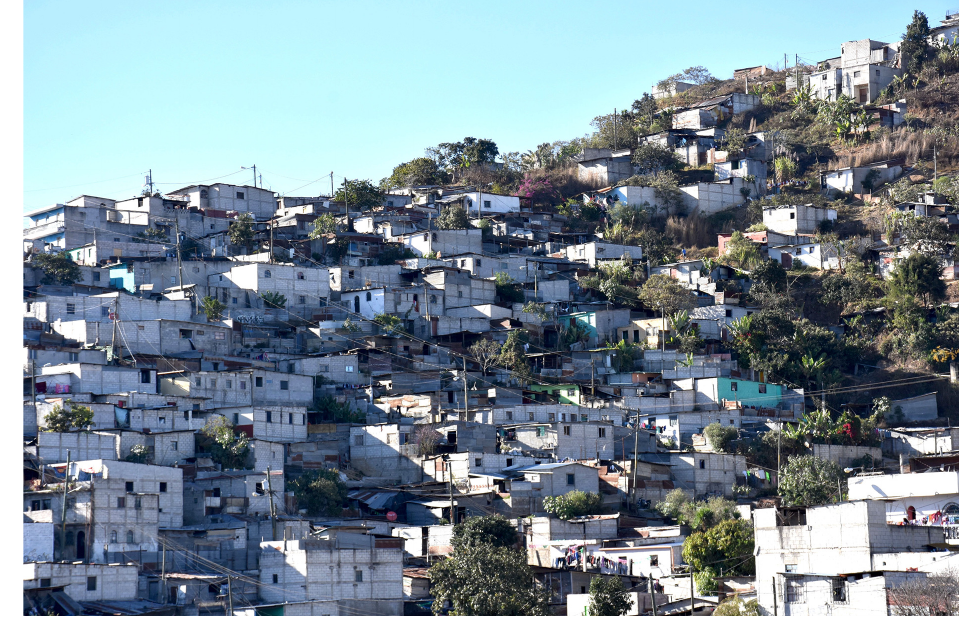
Figure 4. The community in front of Arzú, some parts of which are controlled by gangs. sons—are his only means of support. He seldom leaves